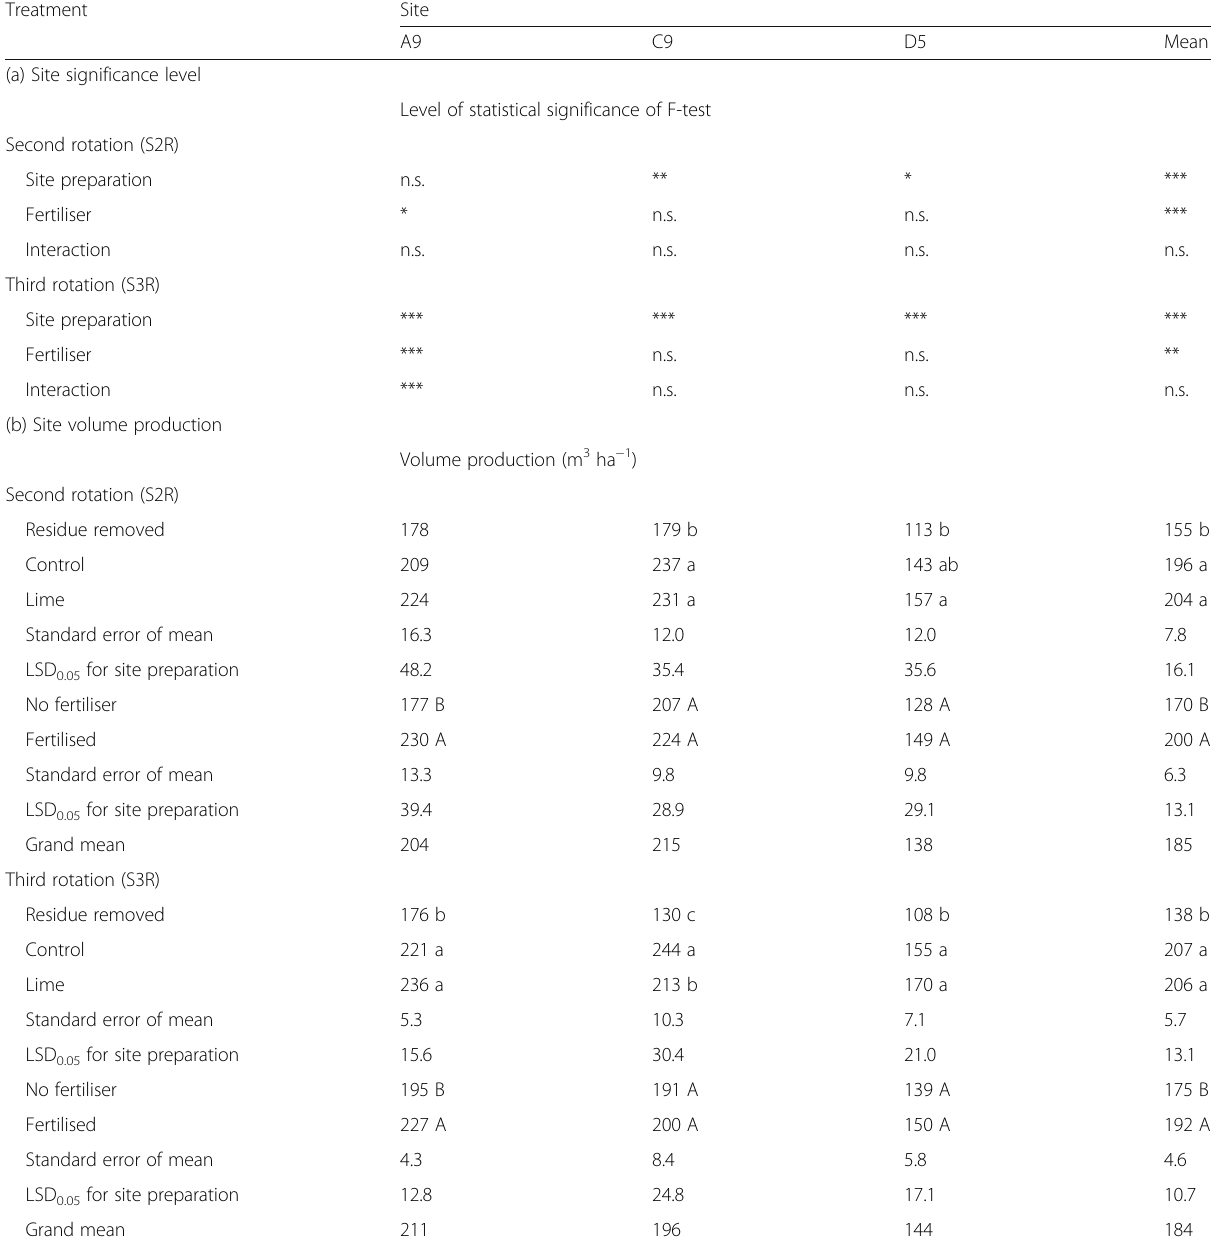
Table 7 The ANOVA summary (a) significance level and (b) volume production per main treatment over three sites at age 9 years from the second and third rotation trials established in